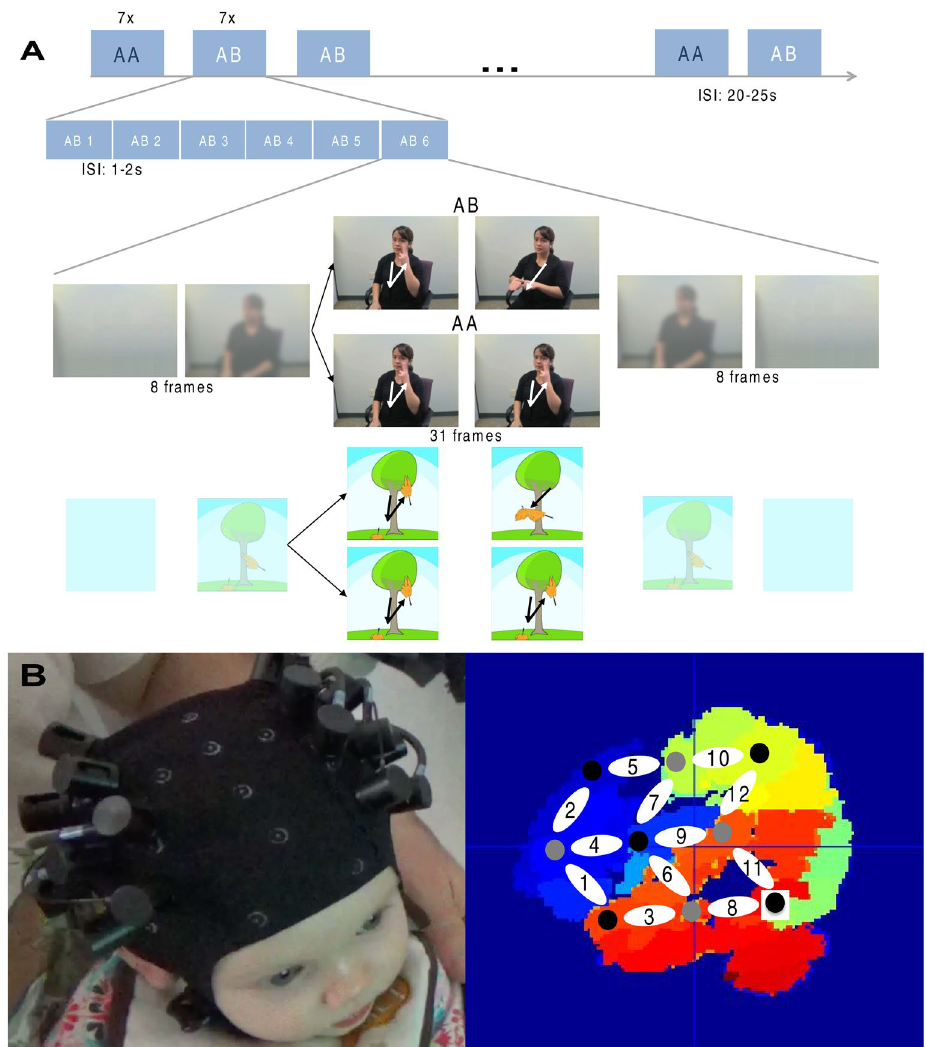
Figure 1. ( A ) The design and the stimuli of Experiments 1 and 2. Upper boxcar: Each experiment featured stimuli of two types: AA and AB. Each condition was presented in seven blocks for a total of 14 blocks. Each block featured six distinct stimulus pairs—either linguistic signs (Experiment 1) or non-sign visual analogs (Experiment 2). One example of an AB block is shown in the second boxcar plot. AA blocks had a similar structure. The AA and AB blocks were interspersed and their order was counterbalanced across participants. Lower rows: examples of a matched pair of AA and AB signs, and the corresponding non-sign analogs. Each such sign pair was comprised of 31 frames, preceded and followed by six faded frames and two additional frames. ( B ) left: a participant wearing the NIRS cap; right: localization of the NIRS channels: the optode configuration was overlaid on an average 6-month-old brain atlas; blue: frontal lobe, red: temporal lobe, yellow: parietal love, green: occipital lobe. The localization analysis following Lloyd-Fox et al. 33 and Abboub et al. 34 , using age-appropriate structural MRIs and stereotaxic atlases 35,36 suggests that channels 1, 2, 4, 5 and 13–16 query the frontal lobe, channels 3, 8, 11, 17, 22, and 24 are positioned over the temporal lobe, channels 10, 12, 20 and 23 are parietal, whereas channels 6, 7, 9, 18, 19 and 21 span two